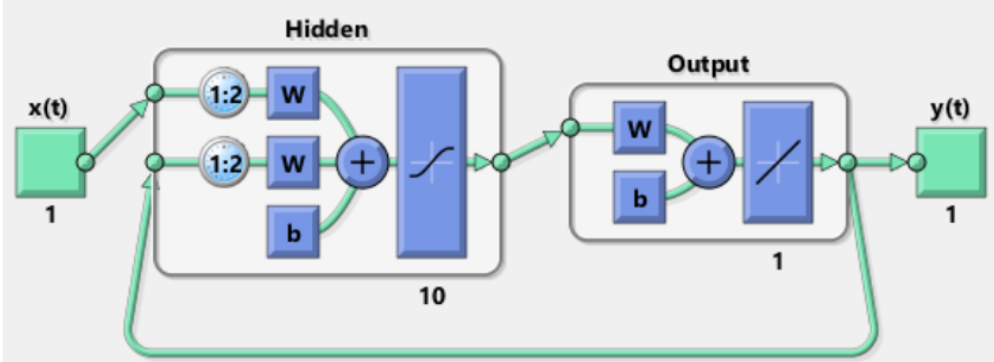
Figure 6. Integration of historical data and experts judgements in NARX, closed-loop